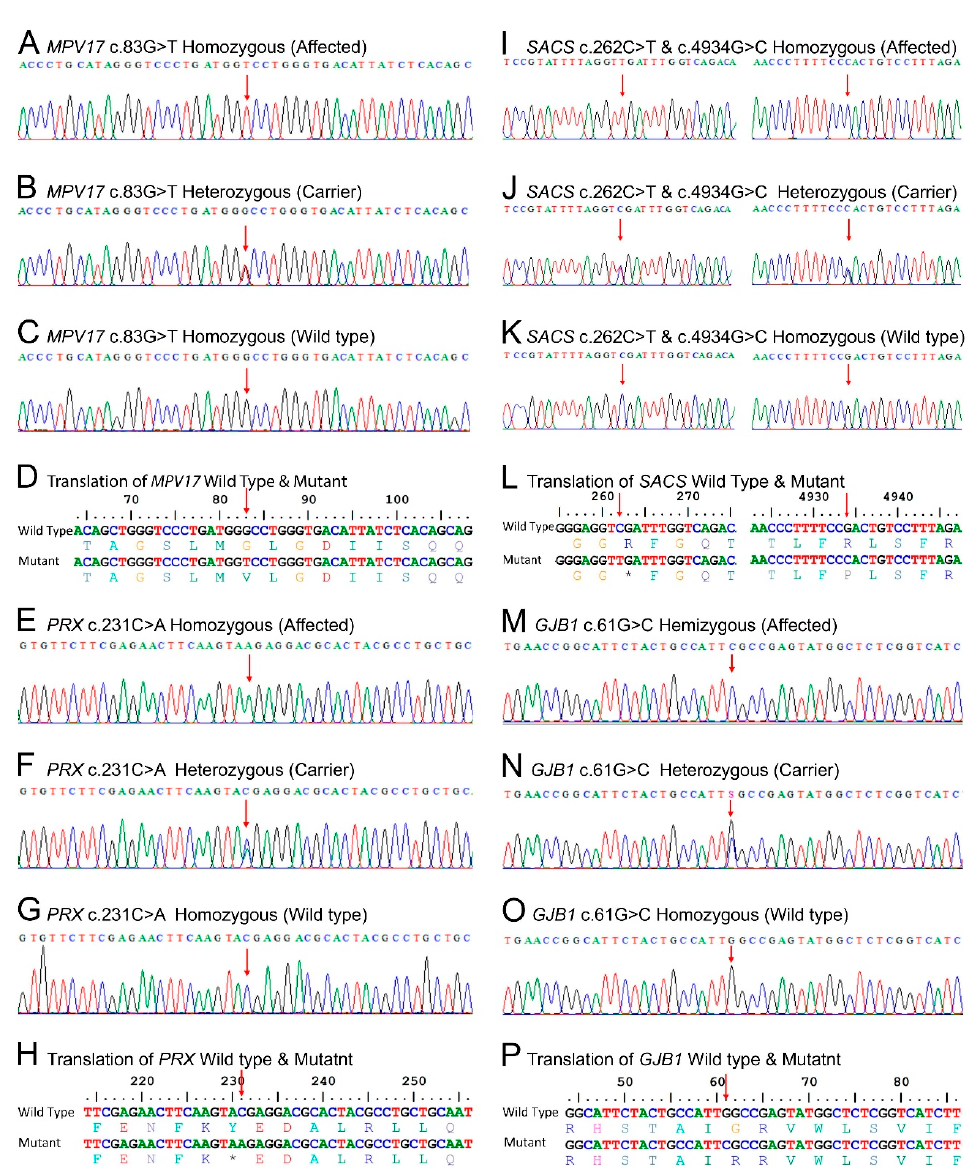
Figure 3. Sanger sequencing trace files were analyzed to identify homozygous mutated, hemizygous mutant, heterozygous carriers, and homozygous wild-type individuals for each gene. The point of alteration is indicated by an arrow above the point of mutation. Figures ( A – C ) show the mutation MPV17 c.83G>T, figures ( E – G ) show PRX c.231C>A, figures ( I – K right ) show SACS